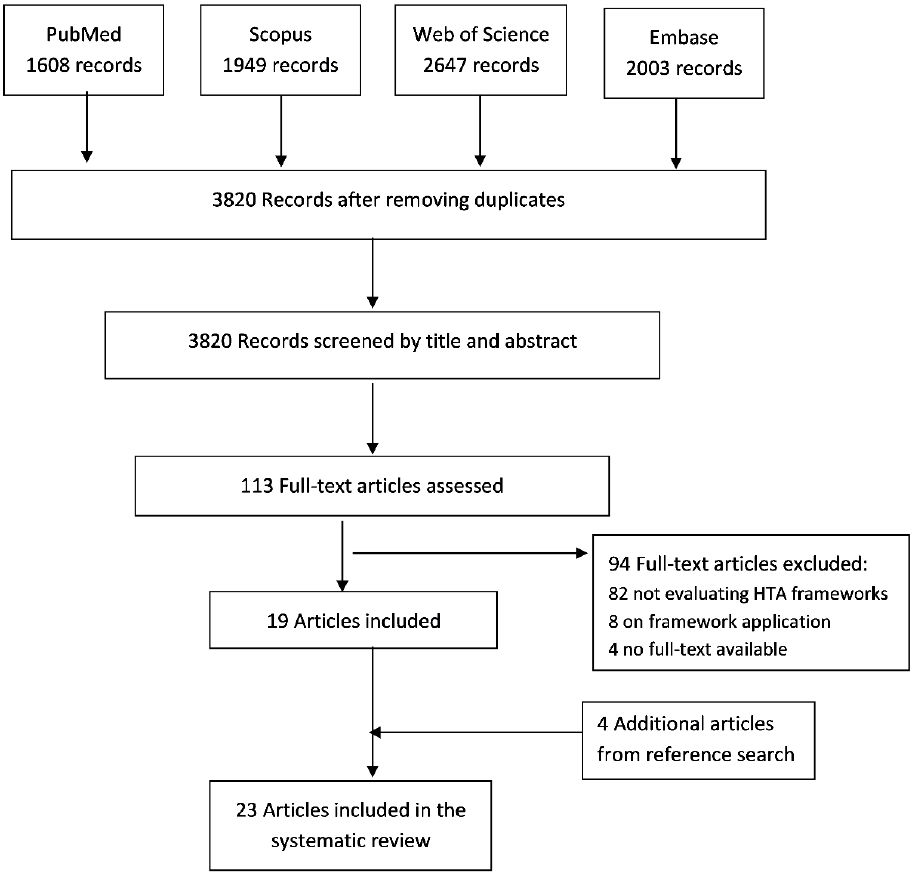
Figure 1. Preferred reporting items for systematic reviews and meta-analyses (PRISMA) flow diagram of the study selection process.